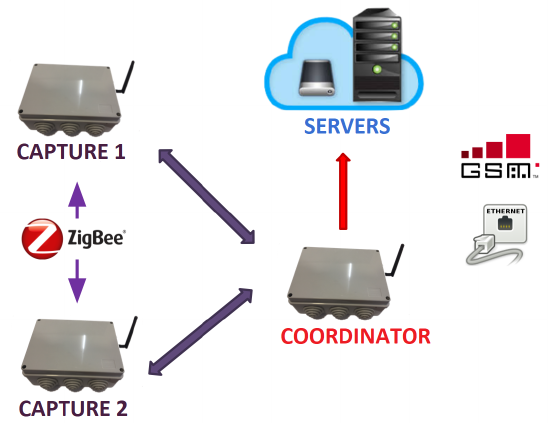
Figure 7. Architecture of the sensor network